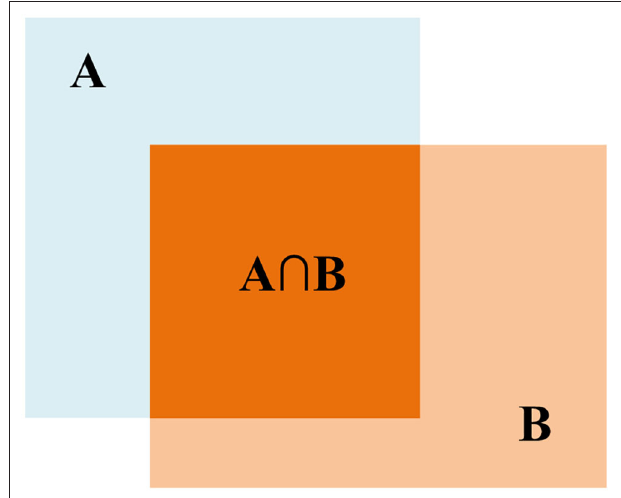
FIGURE 8 | Intersection over union